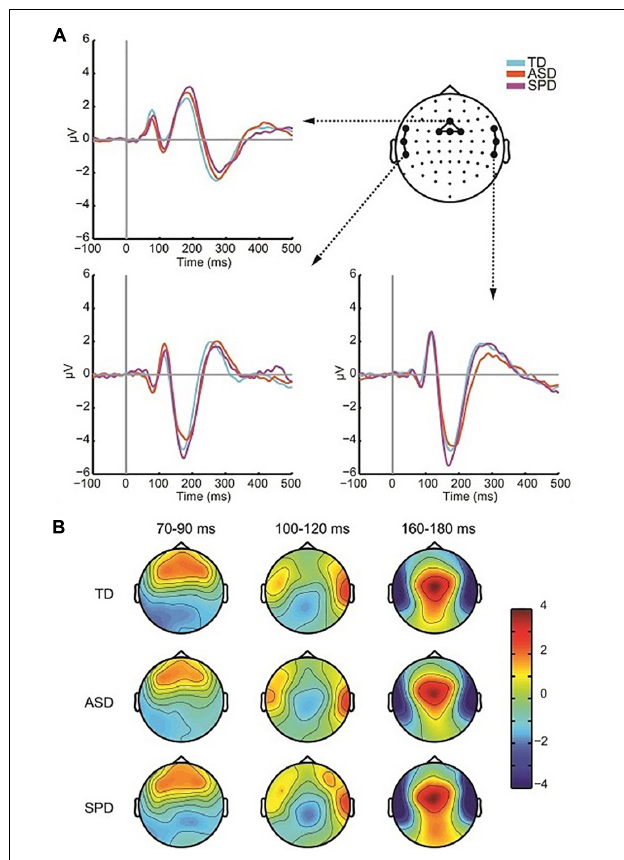
FIGURE 3 | Auditory responses. (A) ERP waveforms in response to the auditory alone condition over fronto-central region as well as left and right temporal regions for each of the three diagnostic groups. (B) Voltage topographies during temporal windows of interest for each diagnostic